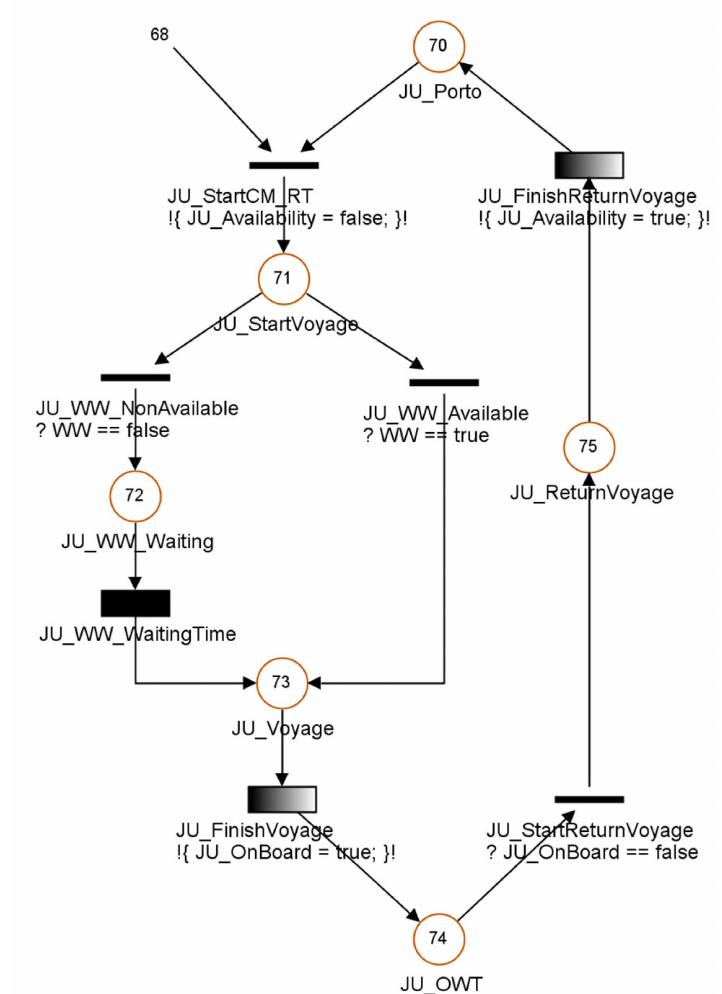
Figure 6. PN model of Jack-up